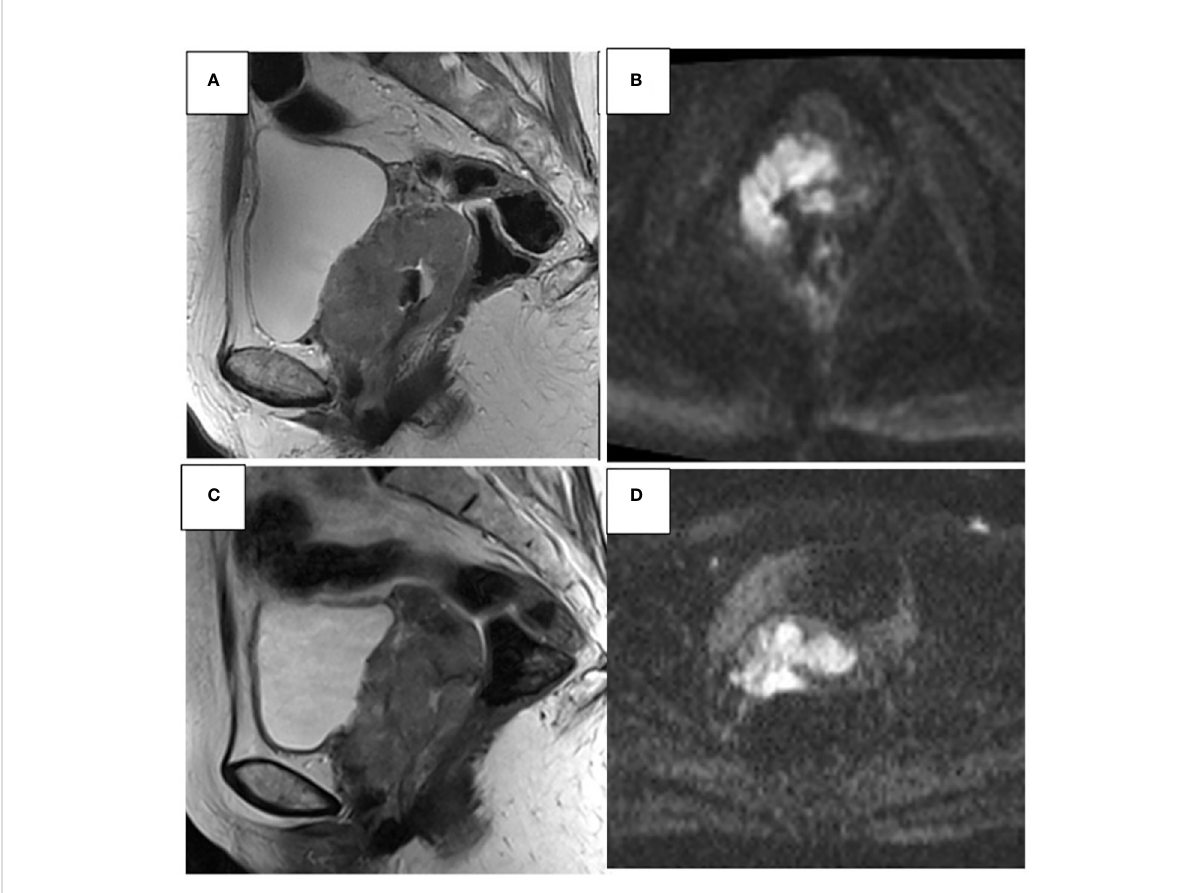
FIGURE 1 45- year-old woman. Sagittal T2W and axial DWI MR images show an invasive CC with parametrial invasion and extension of the upper 2/3 of the vagina (A, B) . Stable disease (C, D) after CCRT, CC is changed in morphology and size; however, in fi ltration of the vaginal fornix, upper 2/3 of the vagina, and both parameters